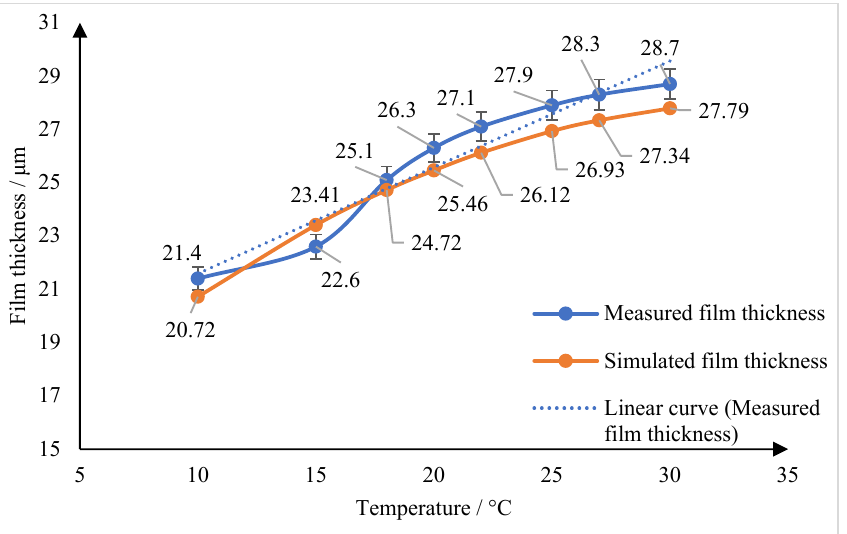
Figure 6. Measured film thickness and simulated film thickness with different temperature (the lines are only guidelines).